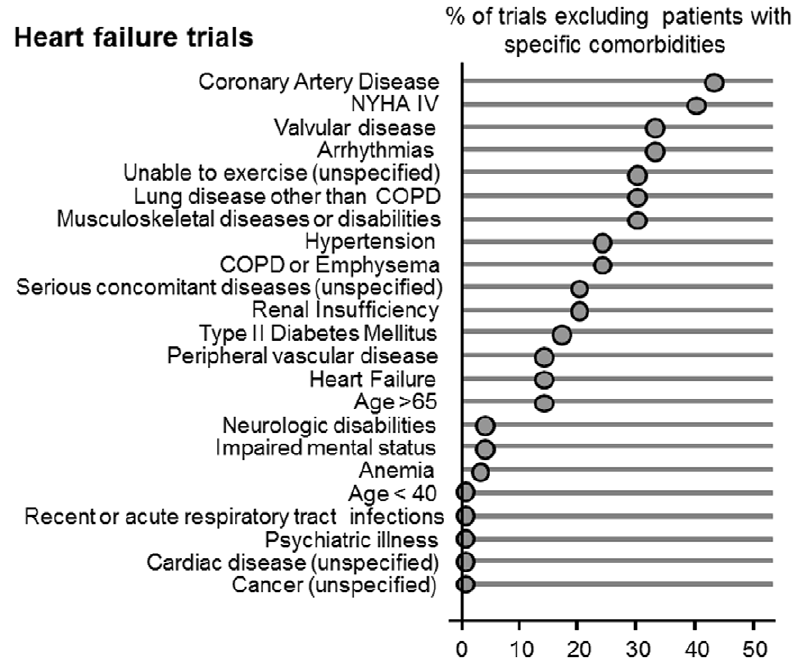
Figure 1. Proportion of heart failure trials where patients with specific comorbidities were excluded.